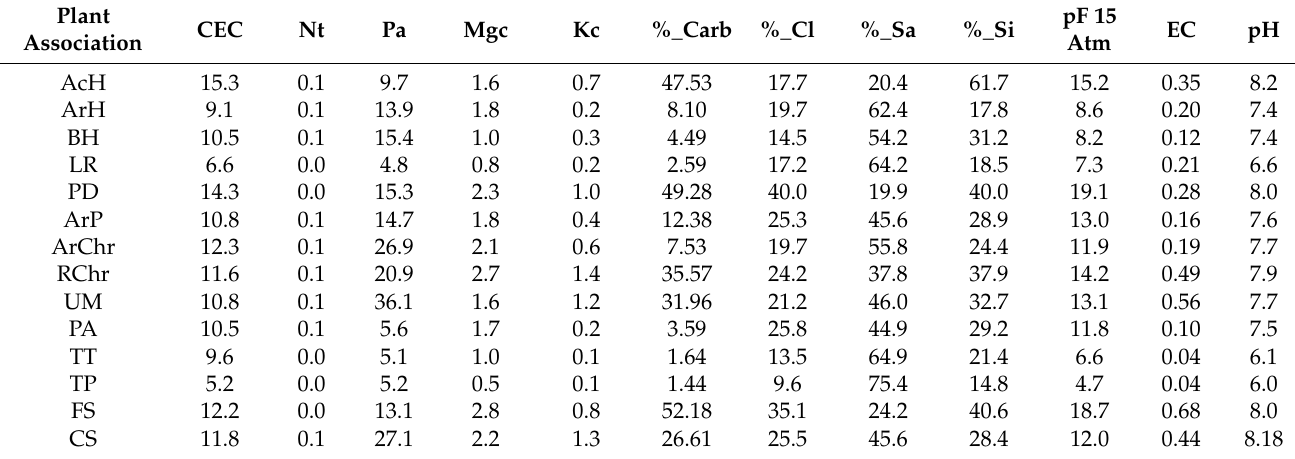
Table 3. Soil parameters of the herbaceous communities in the study. CEC = cation-exchange capacity in cmol/kg; Nt = total nitrogen in %; Pa = assimilable phosphorous in ppm; Mgc = exchangeable magnesium in cmol/kg; Kc = exchangeable potassium in cmol/kg; %_Carb = carbonates in %; %_cl = clay texture in %; %_sa = sand texture in %; %_si = silt texture in %; pF 15 atm = pressure at 15 atmospheres (water retention capacity) in %; EC: conductivity in ds/m;